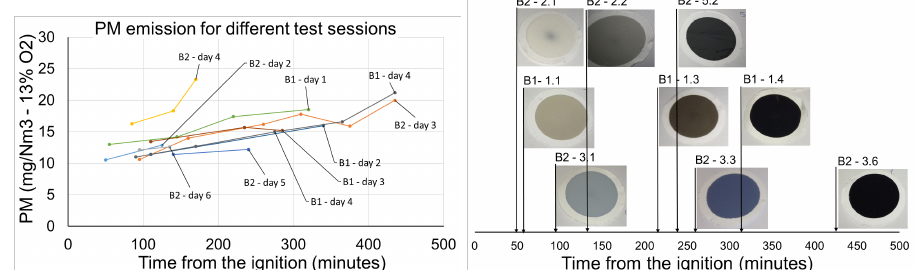
Figure 4. Average PM versus time from ignition for different test sessions for stoves B1 and B2 ( left ); filter color in different tests versus time from ignition ( right ).